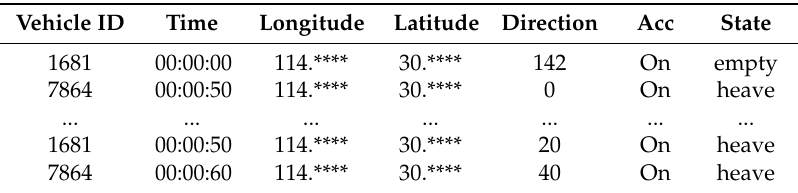
Table 1. Sample records from taxi trajectory